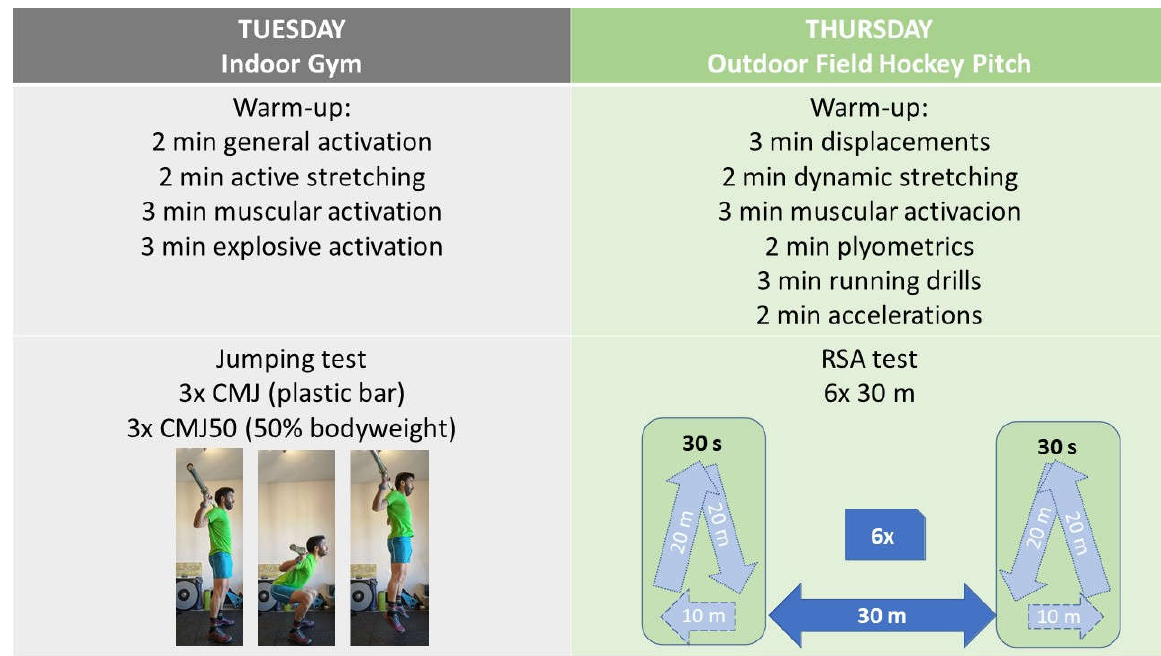
Figure 1. Jumping and RSA test protocols .